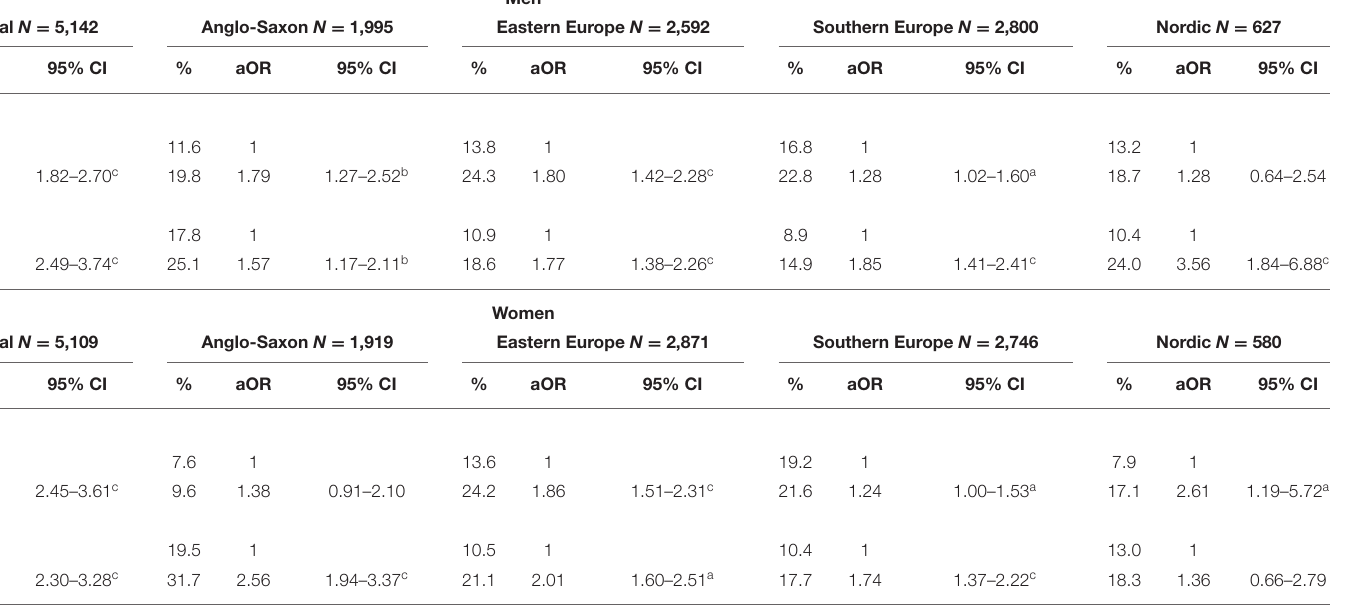
Men Anglo-Saxon N =